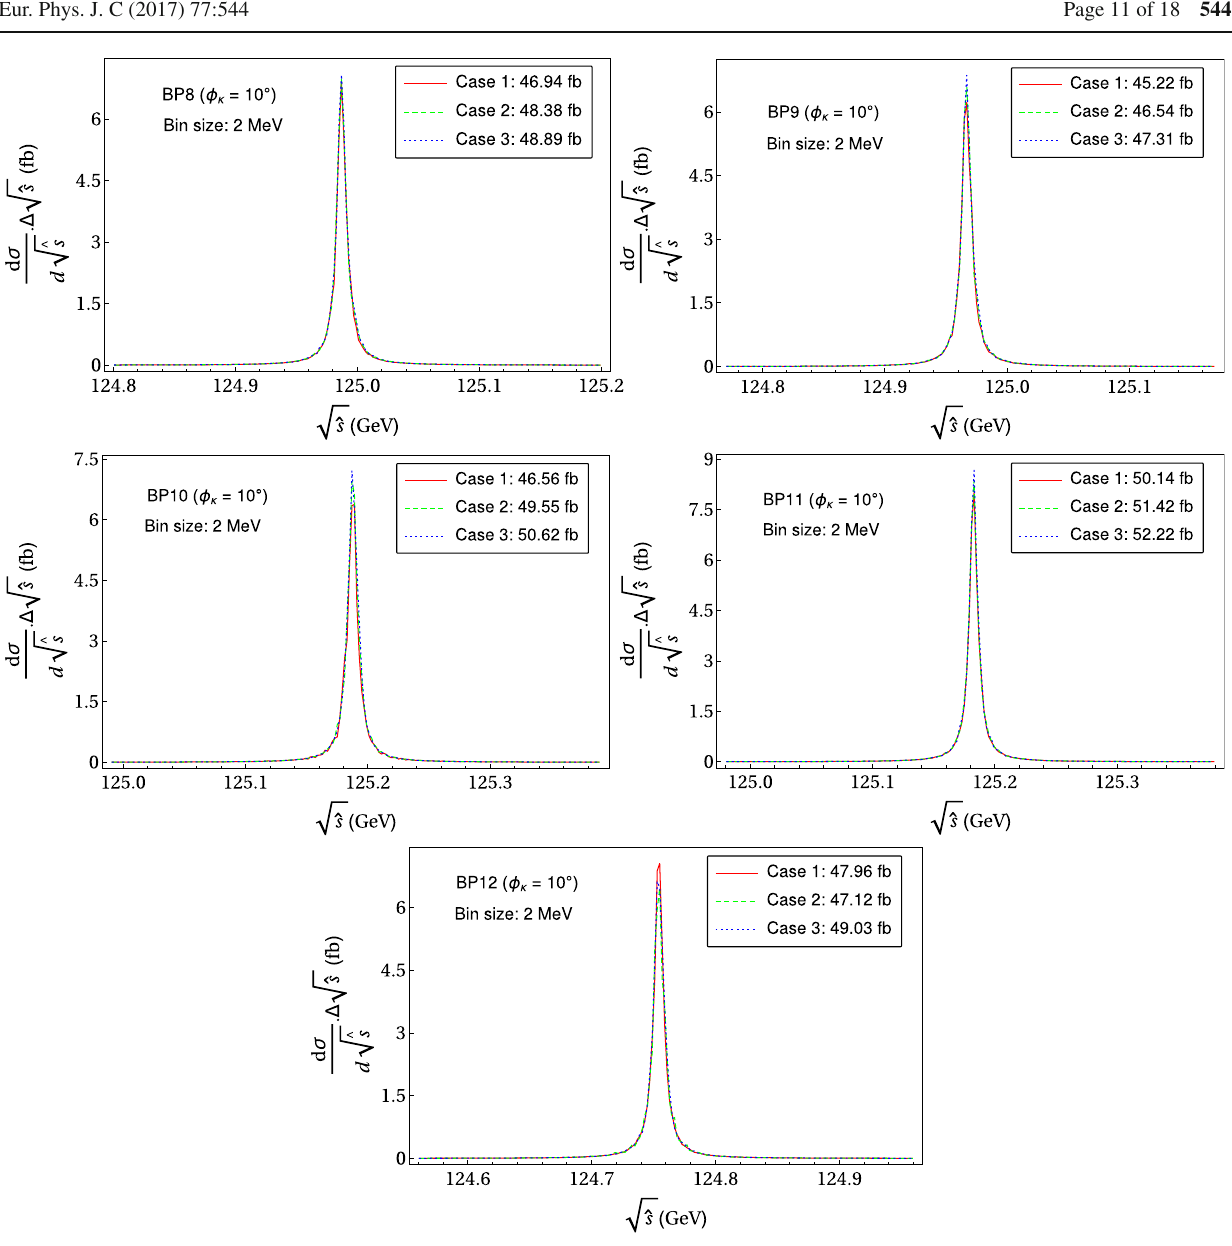
Fig. 5 As in Fig. 3, for the BPs corresponding to the cNMSSM with φ κ = 10